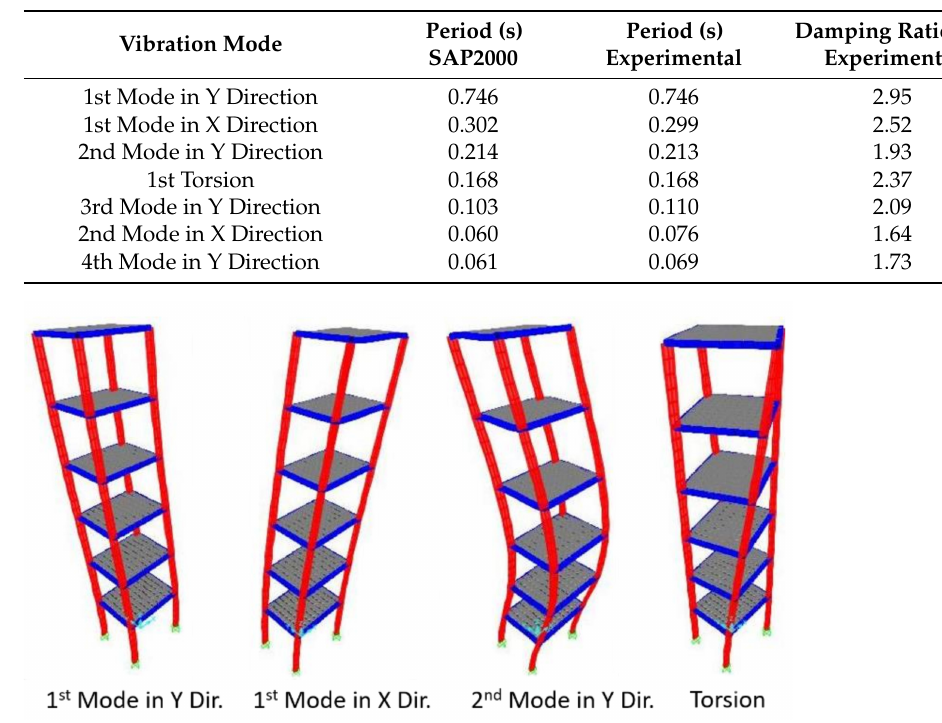
Figure 15. Vibration modes extracted for the